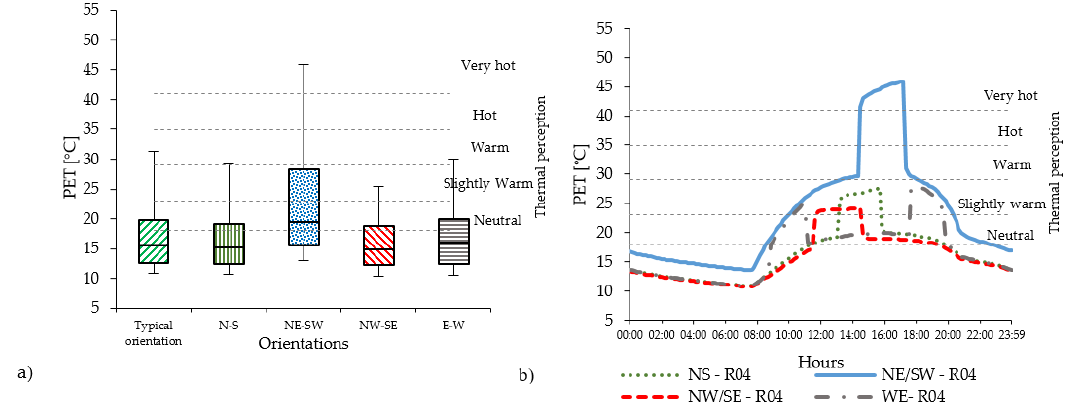
Figure 6. ( a ) PET values measured in all 14 receptors within the UC with asphalt pavement for the open-set high-rise urban areas; ( b ) The PET hourly evolution in R04 in the open-set high-rise UC.